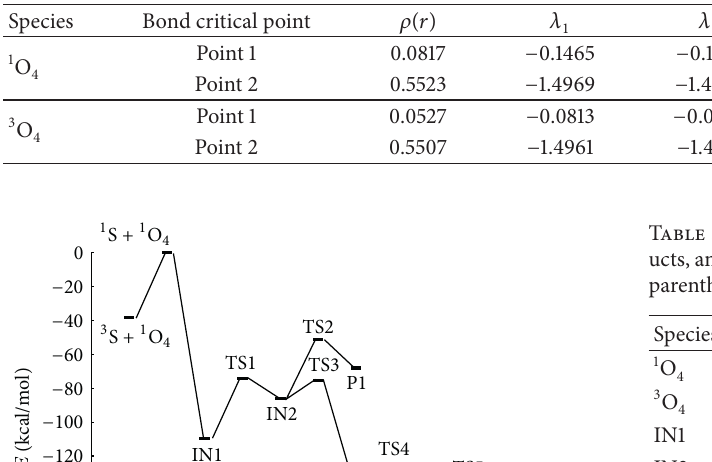
molecules on the B3LYP level; values are in atomic units. 4